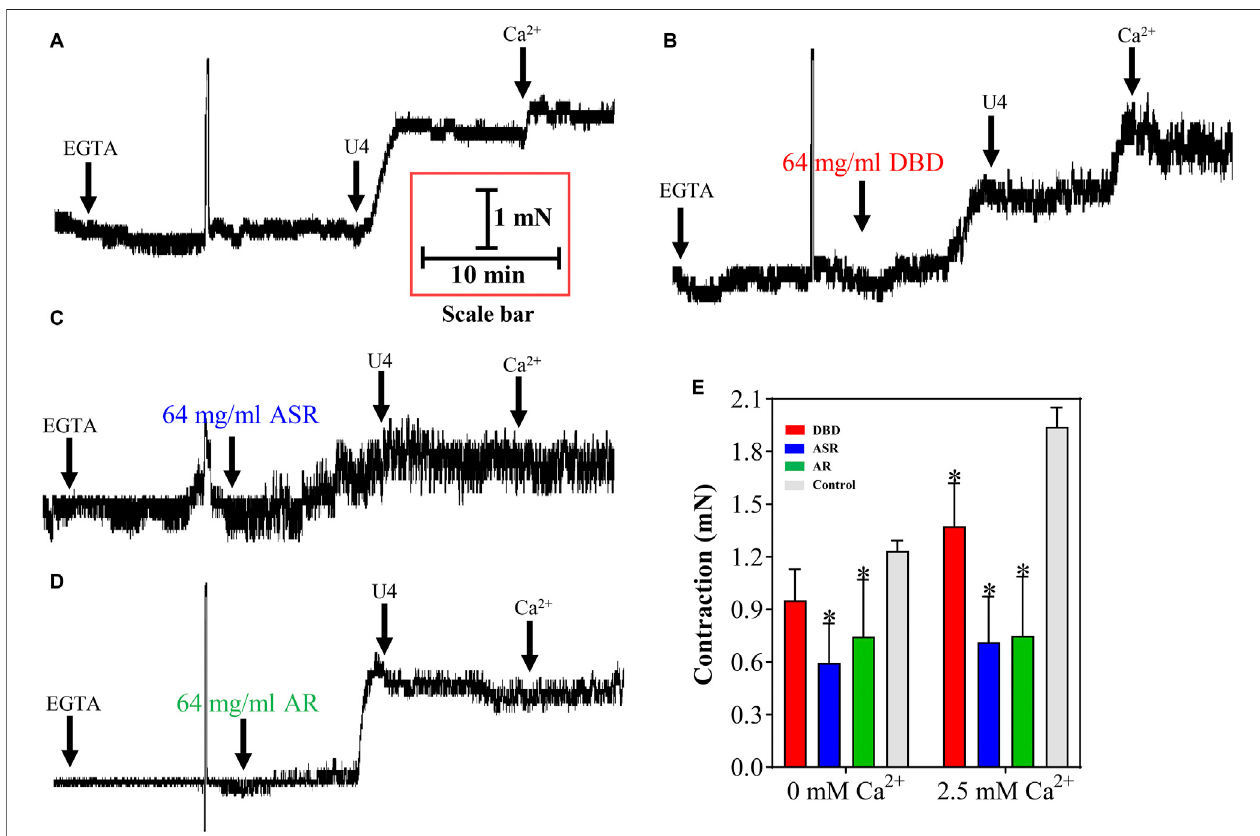
FIGURE 10 | Effect of DBD, ASR, and AR on 1 μ M U46619 precontracted MCA of rats by regulation of [Ca 2+ ] out and [Ca 2+ ] in . (A) U46619 contraction of vessels withoutCa 2+ and secondary contractionofvesselsafter recalci fi cation. TheeffectofDBD (B) ,ASR (C) ,andAR (D) onvasodilationofMCAinthepresence and absence of Ca 2+ . (E) Statistical results and detailed values of DBD, ASR, and AR on [Ca 2+ ] out and [Ca 2+ ] in . [Ca 2+ ] out , the in fl ux of extracellular Ca 2+ . [Ca 2+ ] in , the release of internal Ca 2+ fromorganelles.Datawereexpressed asthemean ± S.E.M.(n (cid:2) 5).* p < 0.05vsthecontrolgroup.DBD,DangguiBuxuedecoction. ASR,AngelicaeSinensis Radix. AR, Astragali Radix. MCA, middle cerebral